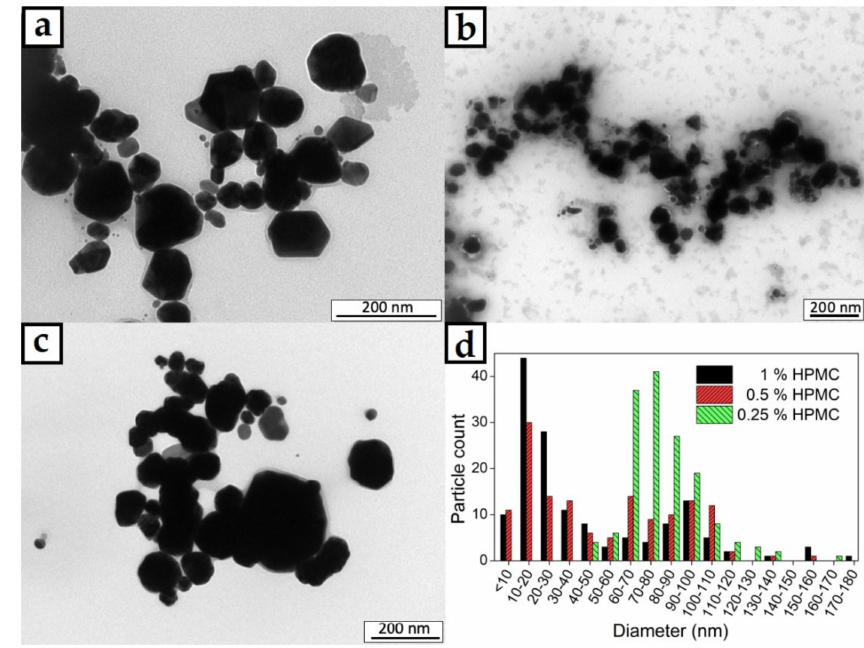
Figure 3. UV–Vis absorption spectra of Silver nanoparticles (AgNPs) colloids prepared by the irradiation of AgNO 3 solutions in ( a ) 0.25%, ( b ) 0.5% and ( c ) 1% HPMC for 15–120 min.